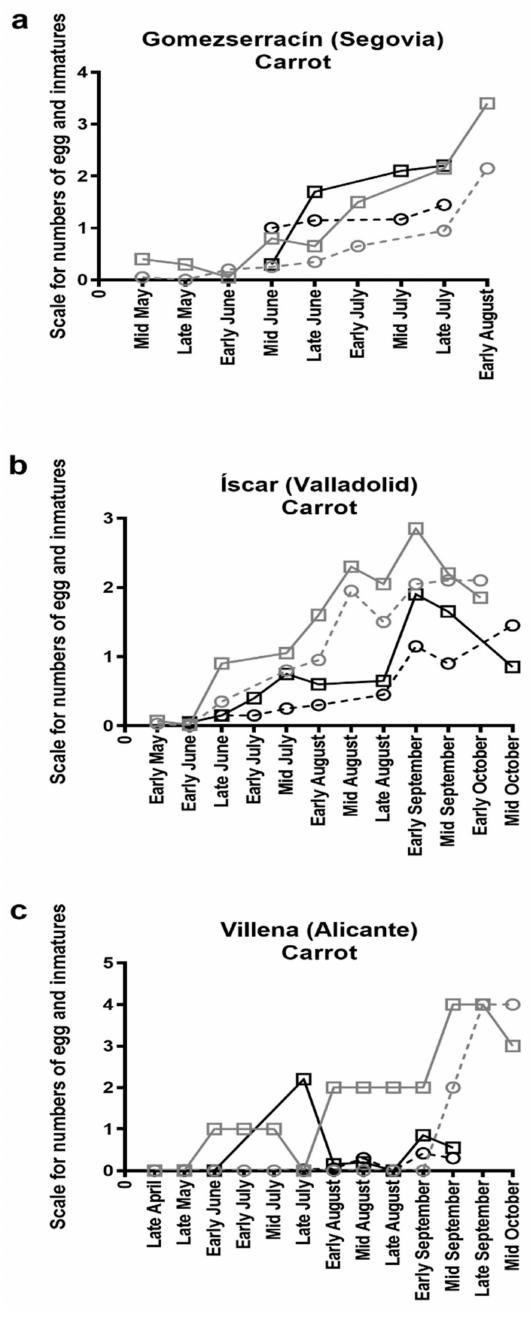
Figure 3. Number of eggs (squares and solid line) and immatures (circles and dashed line) found in 2016 (grey) and 2017 (black) in commercial carrot fields in ( a ) Gomezserrac í n, ( b ) Í scar and ( c ) Villena. Y -axis represents scale values. Scale for eggs and nymphs used was: 0 = 0, 1 = 1–4, 2 = 5–20, 3 = 21–50, 4 = more than